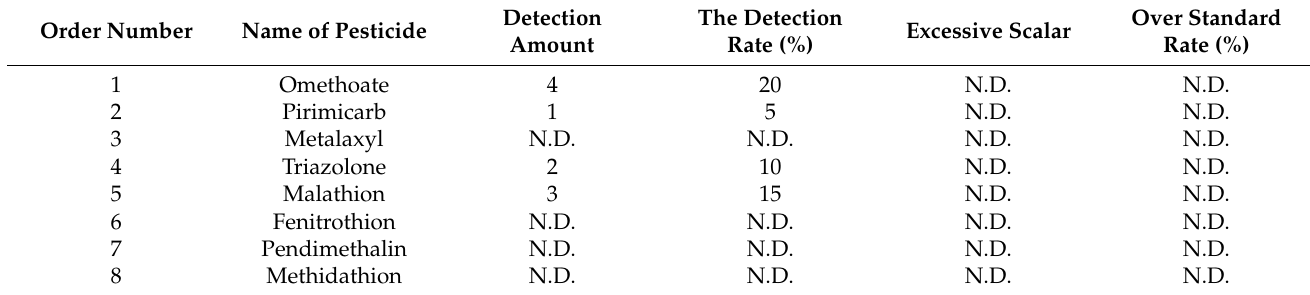
Table 4. Detection results of pesticides residue in